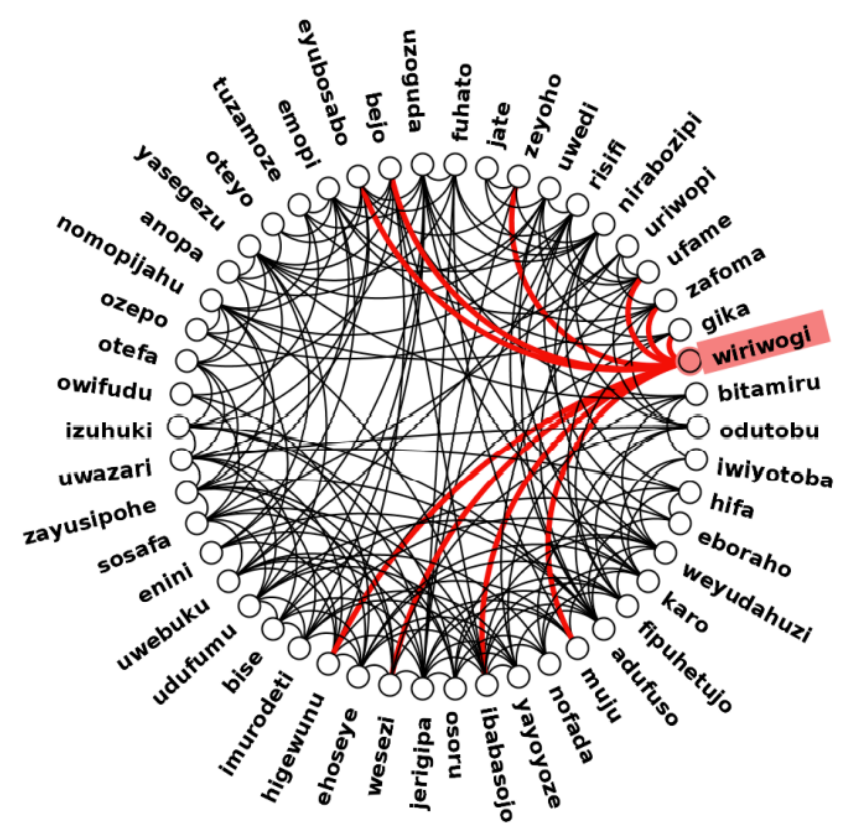
Figure 15. Circular layout [60]. Circular layout of a random 50-node, 200-edge graph, after barycenter